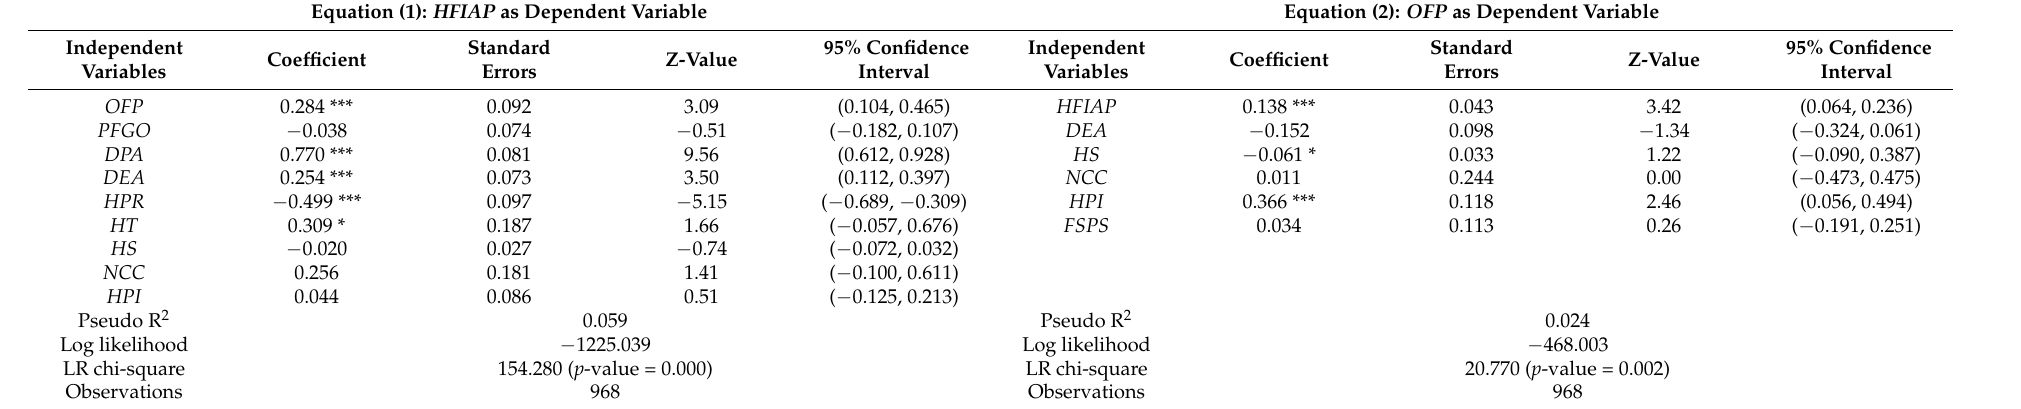
Table 3. Estimated results of simultaneous equations: model I.